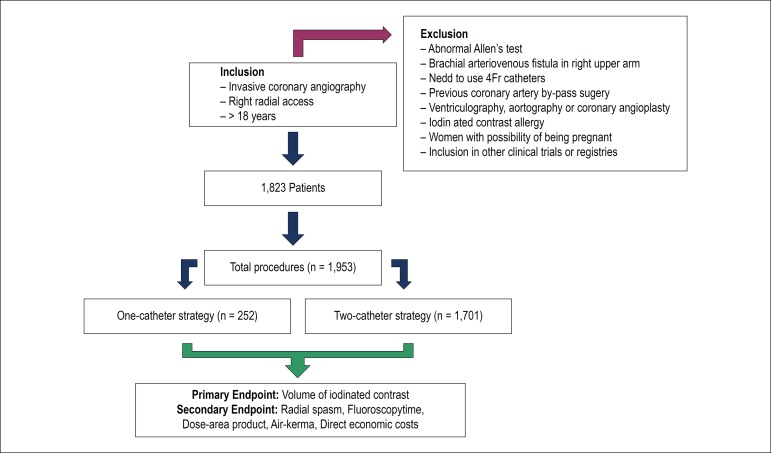
Study Flowchart.